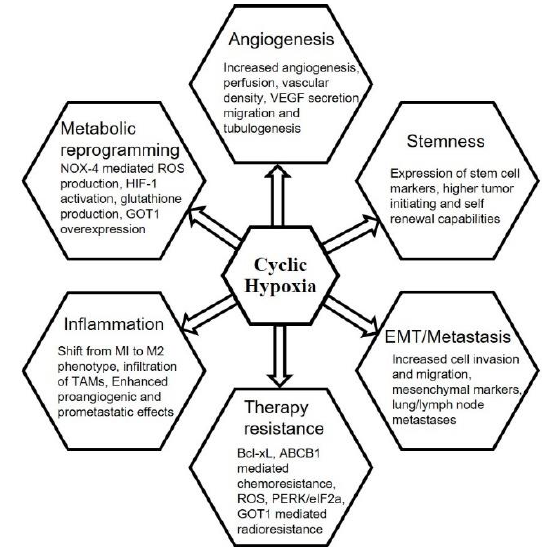
Figure 3. Effect of cycling hypoxia on various hallmarks of cancer. Figure 3. E ff ect of cycling hypoxia on various hallmarks of